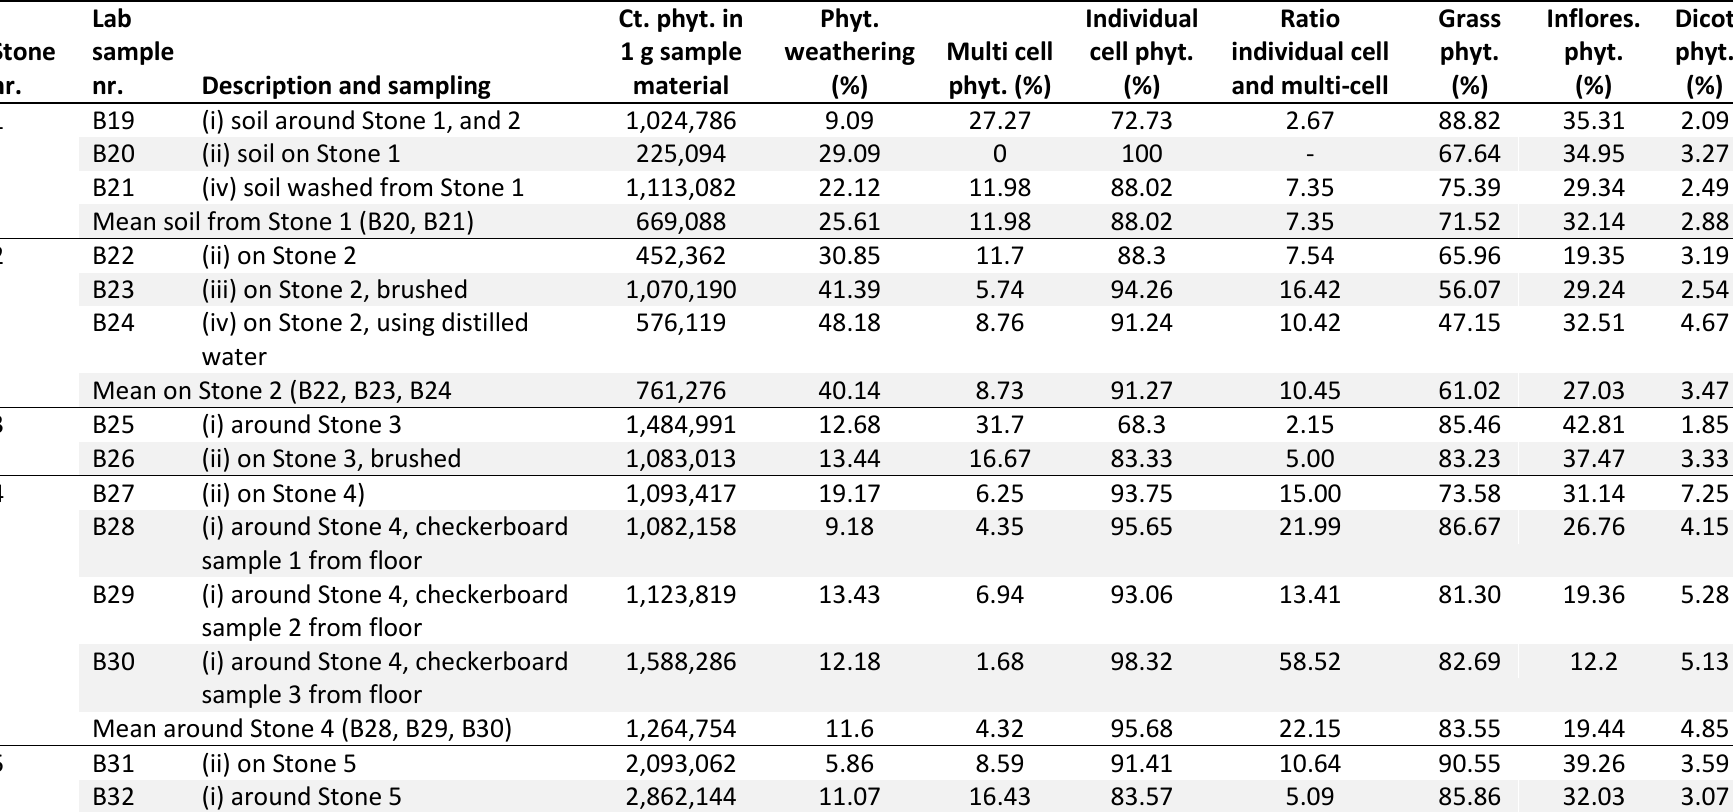
Table 2: Contextual, morphological and residue information and quantitative distribution of phytoliths. The density of phytoliths was calculated on the basis of the initial weight of the sediment in relation to the microscope’s field size (654 mm²), counted fields and counted phytoliths. Percentages (%) are according to all noted phytoliths in the sample. Abbreviations: dicot - phytoliths characteristic of dicotyledonous cells; ct. phyt. - count phytoliths; inflores. phyt. - inflorescence